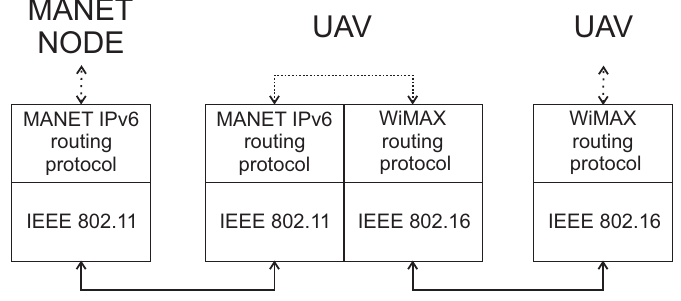
Figure 5. The example of dual protocol stack used in MANET node and